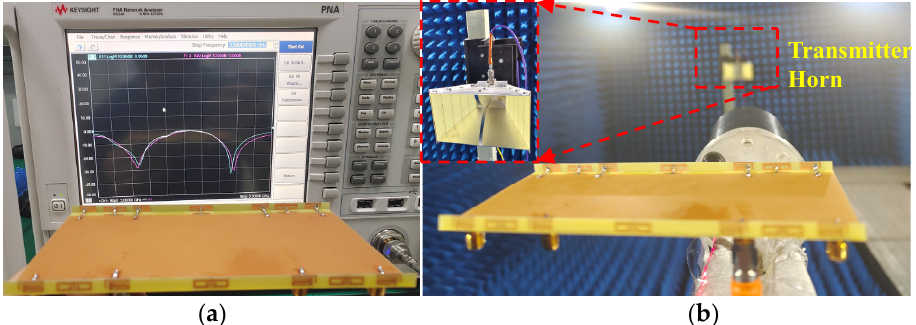
Figure 9. Photograph of the manufactured model of the proposed antenna and the experimental environment ( a ) measured by the VNA and ( b ) measured in the anechoic chamber.